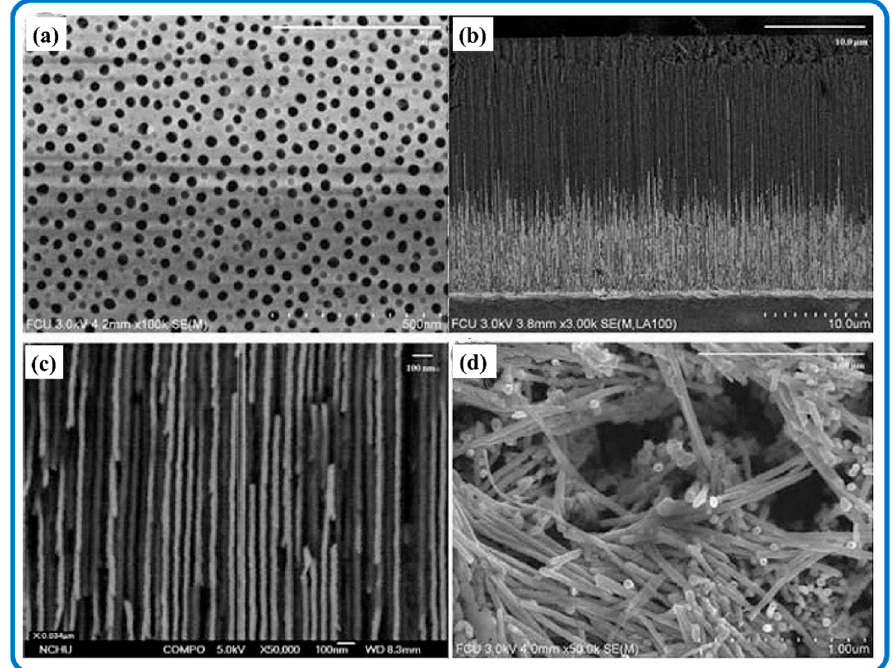
Figure 5. Field Emission Scanning Electron Microscope (FE-SEM) micrographs of ( a ) top view of the AAO templates for SnS 2 nanowire formation, ( b ) cross-section view of SnS 2 nanowires embedded in an AAO template, ( c ) the magnified FE-SEM micrograph of SnS 2 nanowires, and ( d ) SnS 2 nanowires detached from the AAO templates. Reproduced from [121]. 2009, Springer. CC BY 2.0 .